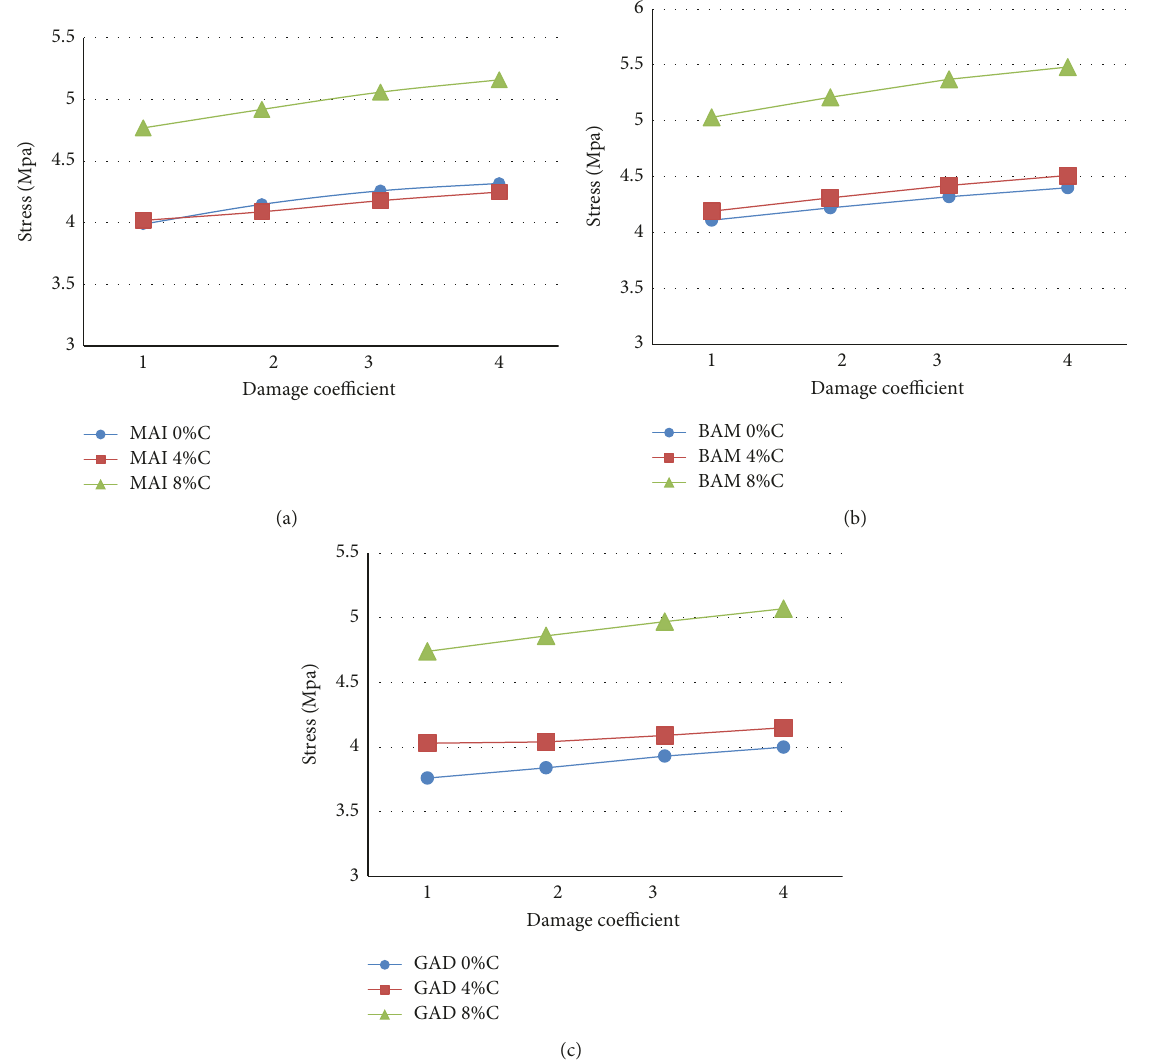
Figure 11: Compression stress compared to the damage coefficient of CEBs and